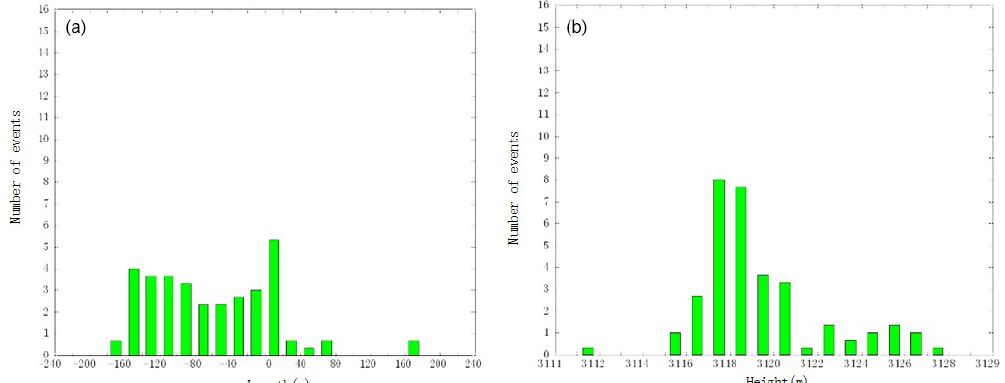
Figure 7. Frequency chart of events in different dimensions ( a : horizontal; b : vertical).